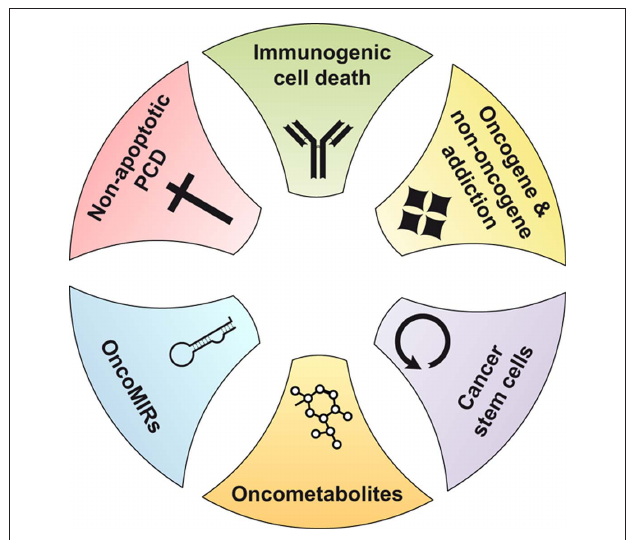
Figure 1 | The great discoveries of the last decade of molecular and cellular oncology research. MIRs, microRNAs; PCD, programmed cell